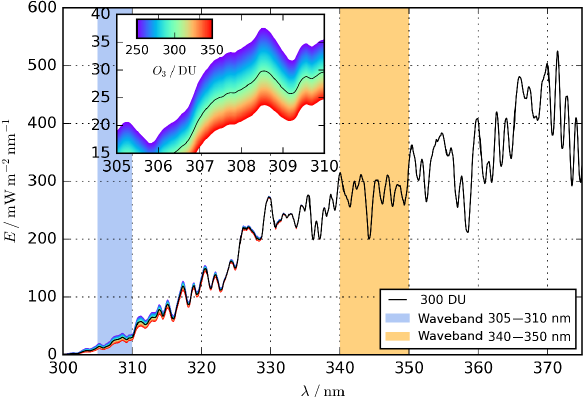
Figure 6. Direct irradiance spectra of the lookup table modelled with libRadtran. Shown are all spectra for an SZA of 48 ◦ , ranging from 250 (purple) to 320DU (red) TOC. The wavebands used for the TOC retrieval are marked blue and